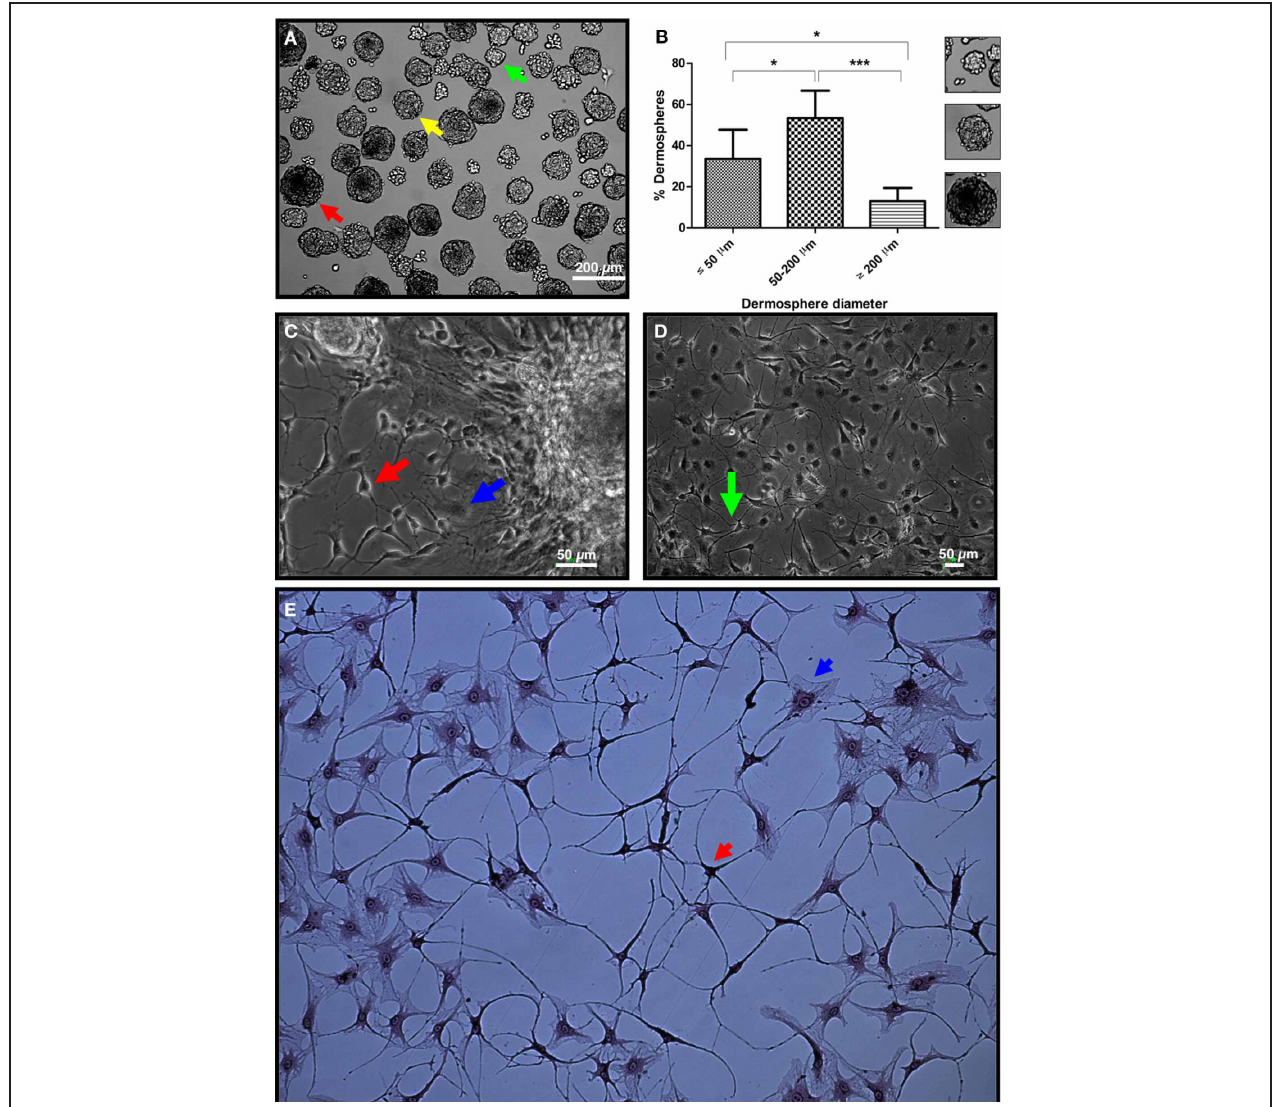
seeded onto the developed extracellular matrix in neuronal inducing medium showed apparent neurons with a clear polar morphology and neurite emissions (red arrow), as well as seemingly undifferentiated stromal cells (blue arrow) after 7 days in differentiation conditions. (D) A neuronal network was apparent after 10 days differentiation (green arrow). (E) Neuronal phenotype was confirmed by Bodian’s silver proteinate staining (red arrow), although stromal cells non-differentiated to the neural lineage were also seen (blue